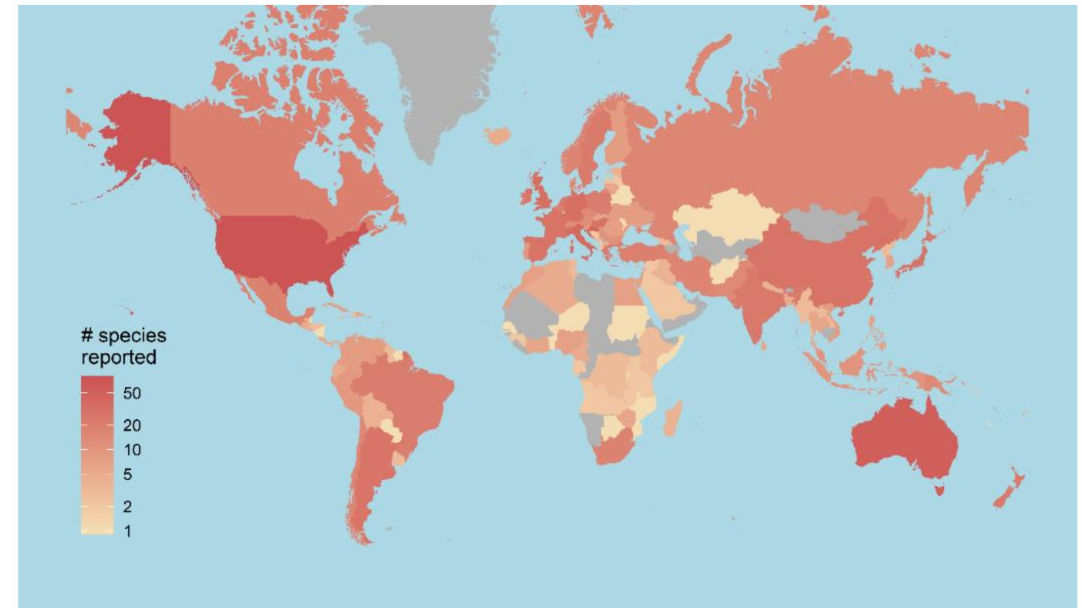
Figure 3. The number of different Phytophthora species reported in each country, based on records in the global Phyto- threats